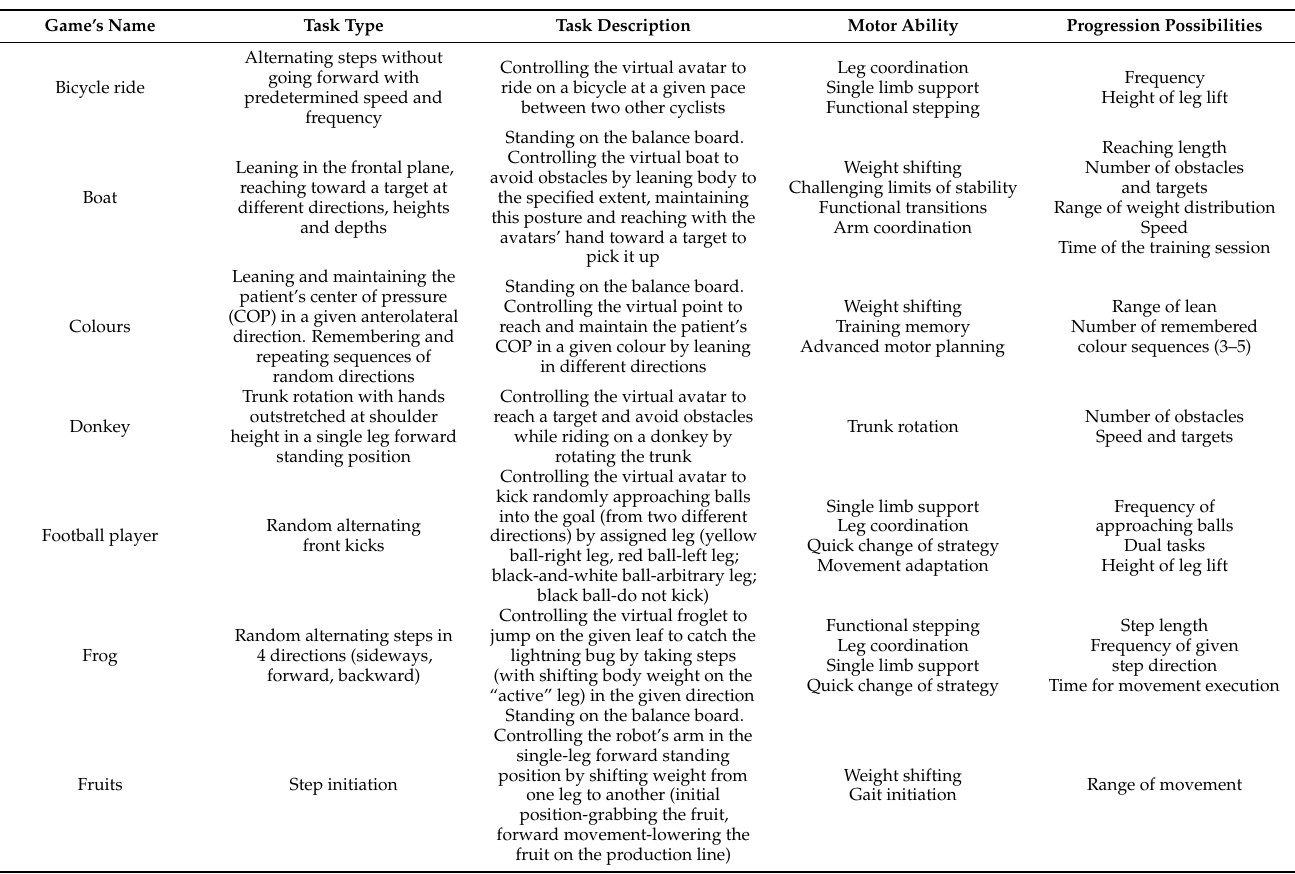
Table 2. Virtual Balance Clinic games’ types, adapted from Ref. [10], Gait Posture 2021, on the basis of the International Association of Scientific, Technical & Medical Publishers (STM) Permissions